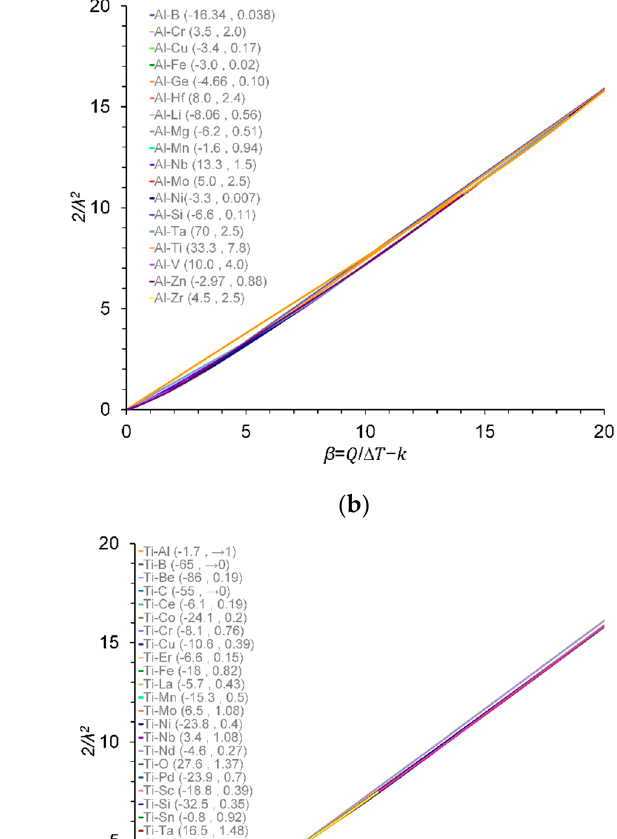
Figure 1. Variation in 2/ λ 2 values with the ratio of Q . to Δ T at Δ T = 0.5 K for ( a ) Cu–X; ( b ) Al–X; ( c ) Mg–X; and ( d ) Ti–X binary alloys; ( e ) zoom-in region from (a). The m and k values are given in parentheses ( m and k ), data from [9,22,23,25–31]. The m and k values for the Al–B binary alloy were calculated in this work.